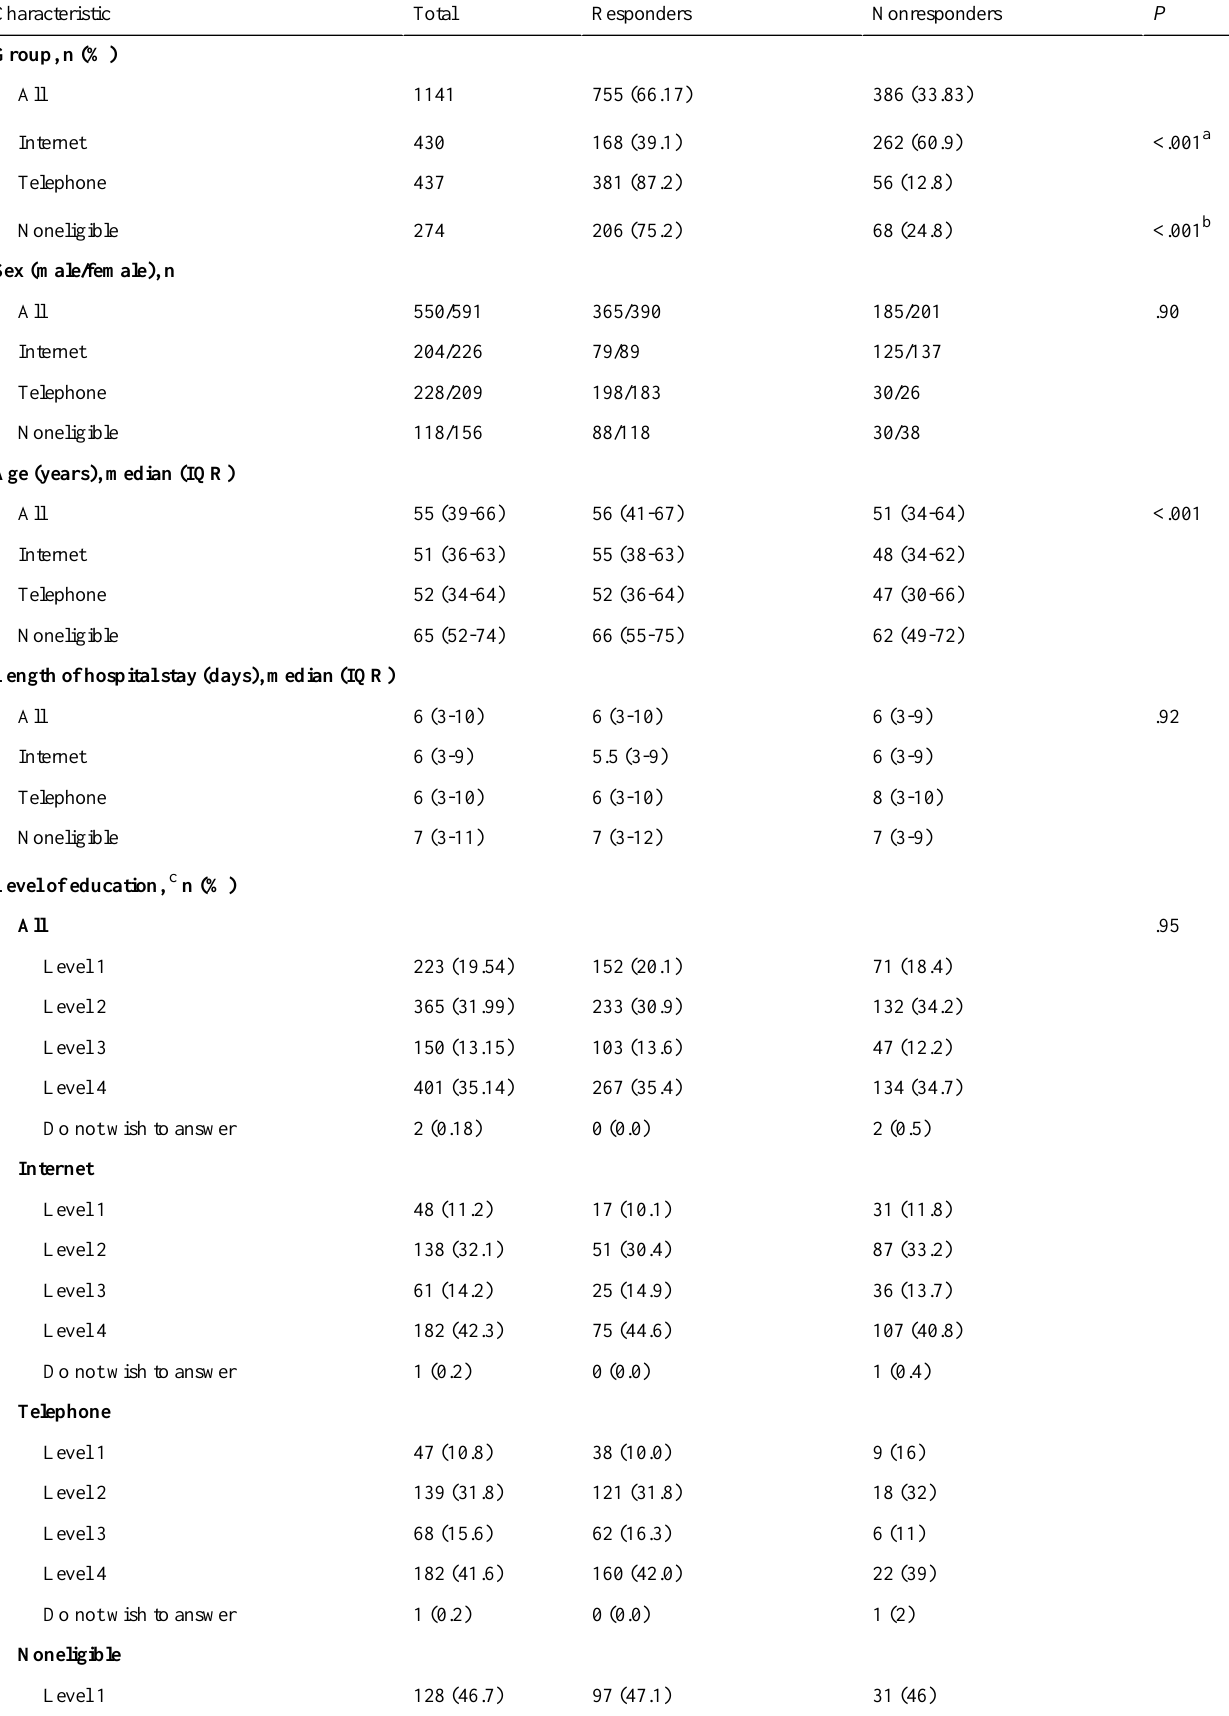
Table 2. Characteristics of patients with a hospital stay of 2 or more days.